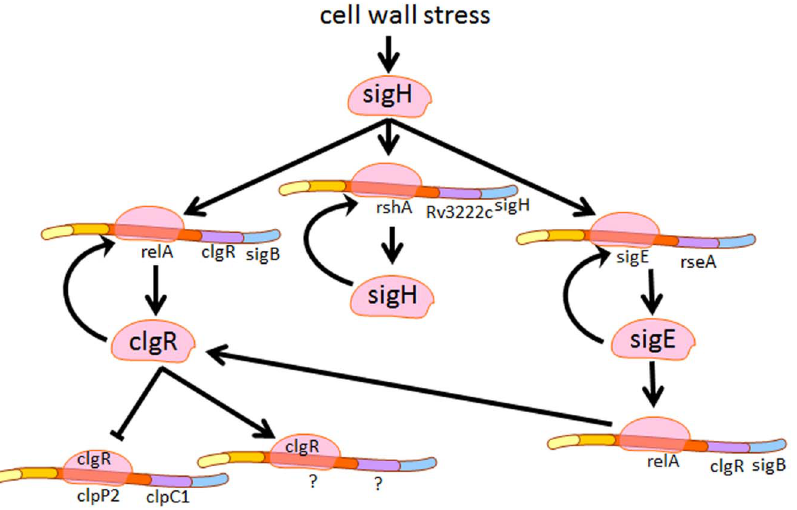
Figure 8. clgR activation schematic. Proposed overview of possible clgR activation upon cell wall stress. Induction of the s H regulon requires clgR activation. However, it is unclear if induction of the s H regulon is through direct or indirect effects of clgR